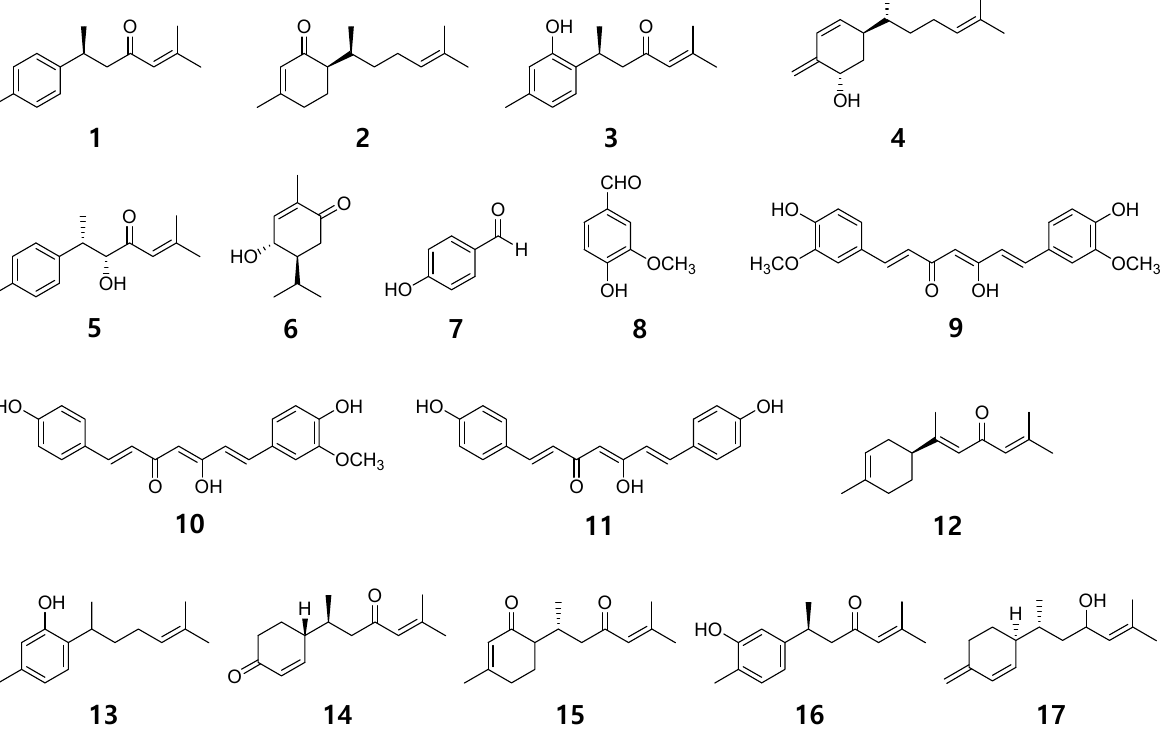
Figure 1. Chemical structures of compounds 1 – 17 from C. longa .